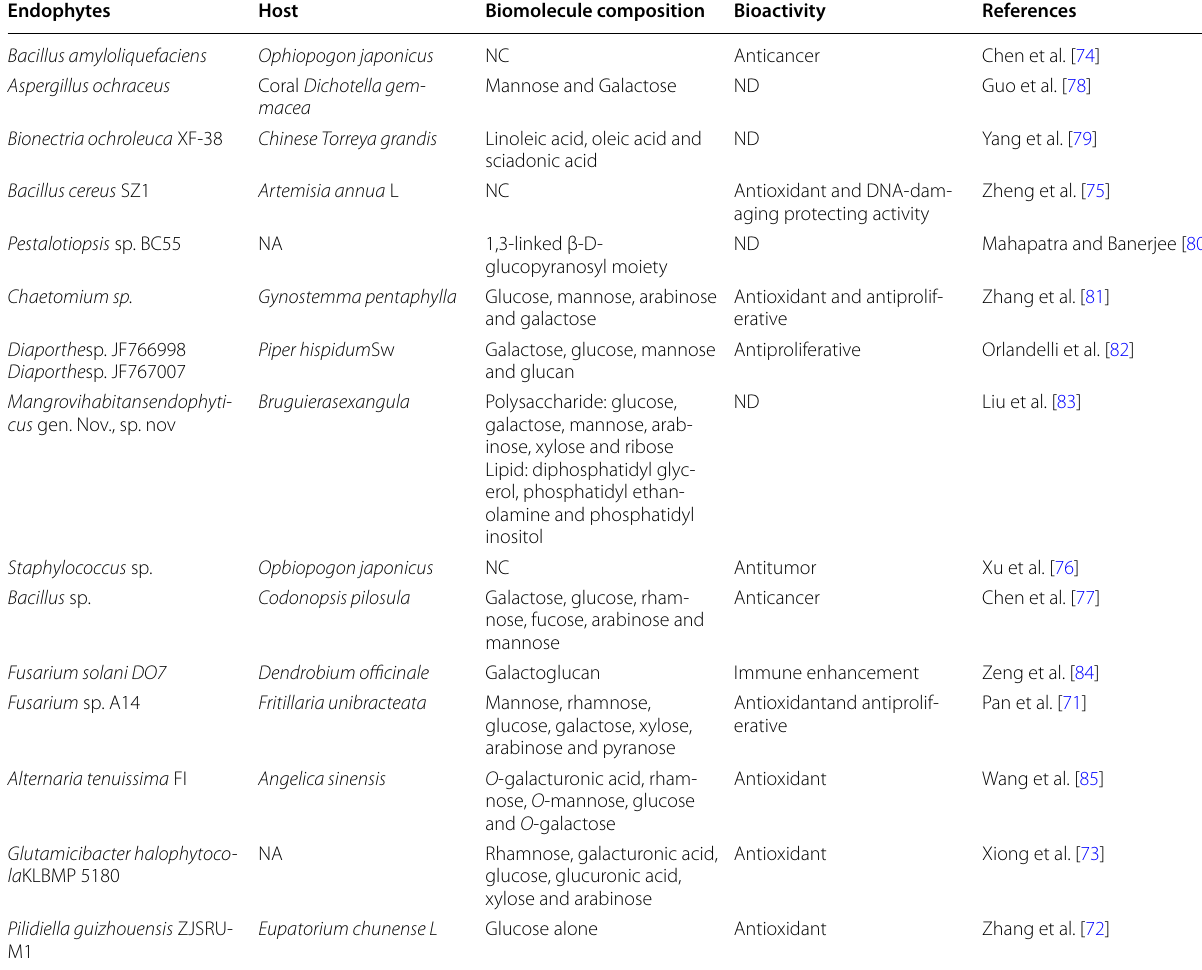
NA: Not available; NC: not characterized; ND: not